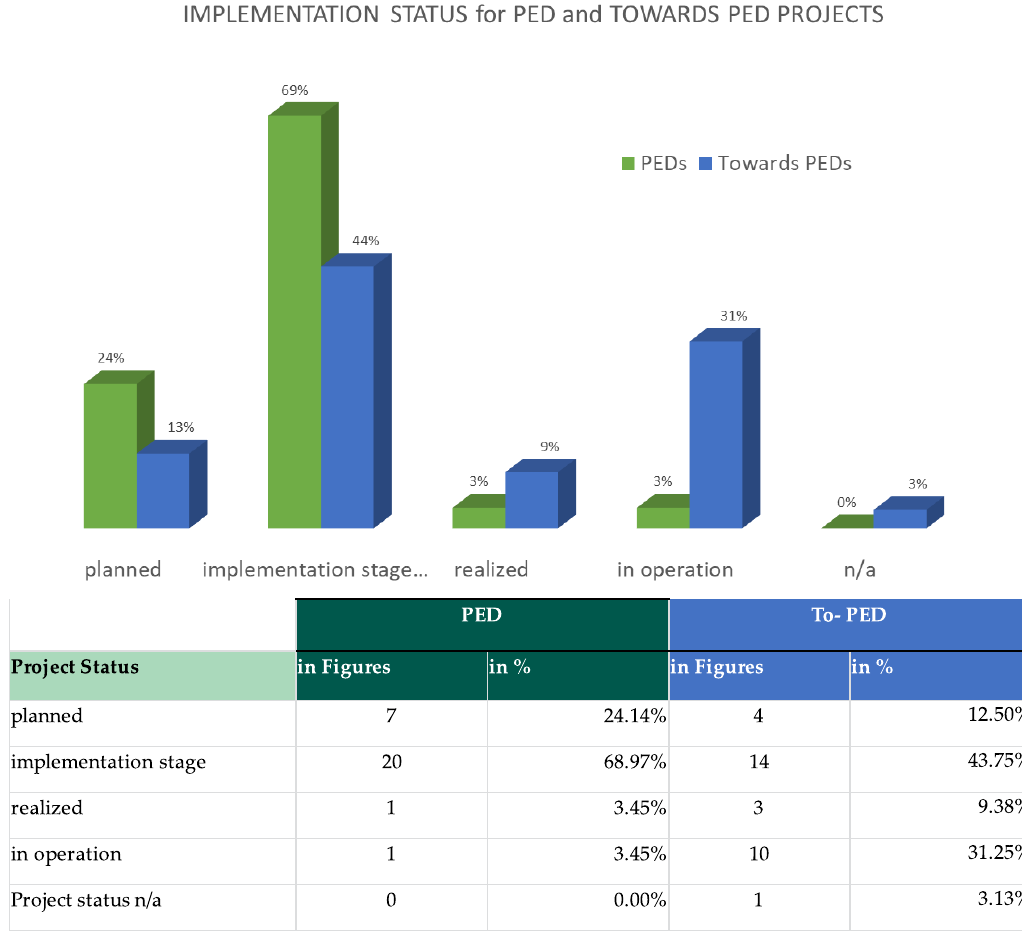
Figure 1. Implementation status of Positive Energy District and Neighborhood (PED) versus Toward (To)-PED.